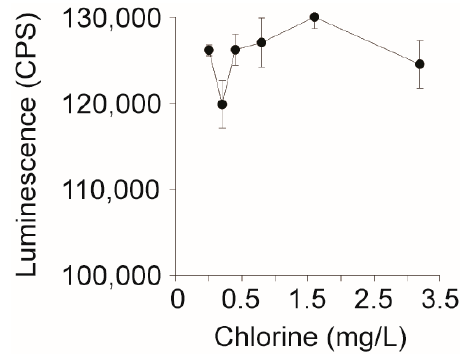
Figure 3. Effect of chlorine levels on the performance of the HeLa cell-based assay. Sodium Figure 3. E ff ect of chlorine levels on the performance of the HeLa cell-based assay. Sodium hypochlorite hypochlorite (bleach) was diluted two-fold from 3.2 to 0.2 mg/L and 5 μ L was added to 10 4 HeLa cells (bleach) was diluted two-fold from 3.2 to 0.2 mg / L and 5 µ L was added to 10 4 HeLa cells in DMEM, in DMEM, which were incubated for 24 h at 37 °C with CO 2 . Cell viability was measured using Cell which were incubated for 24 h at 37 ◦ C with CO 2 . Cell viability was measured using Cell Titer Glo and Titer Glo and luminescence was measured on a Victor3 plate reader. luminescence was measured on a Victor3 plate